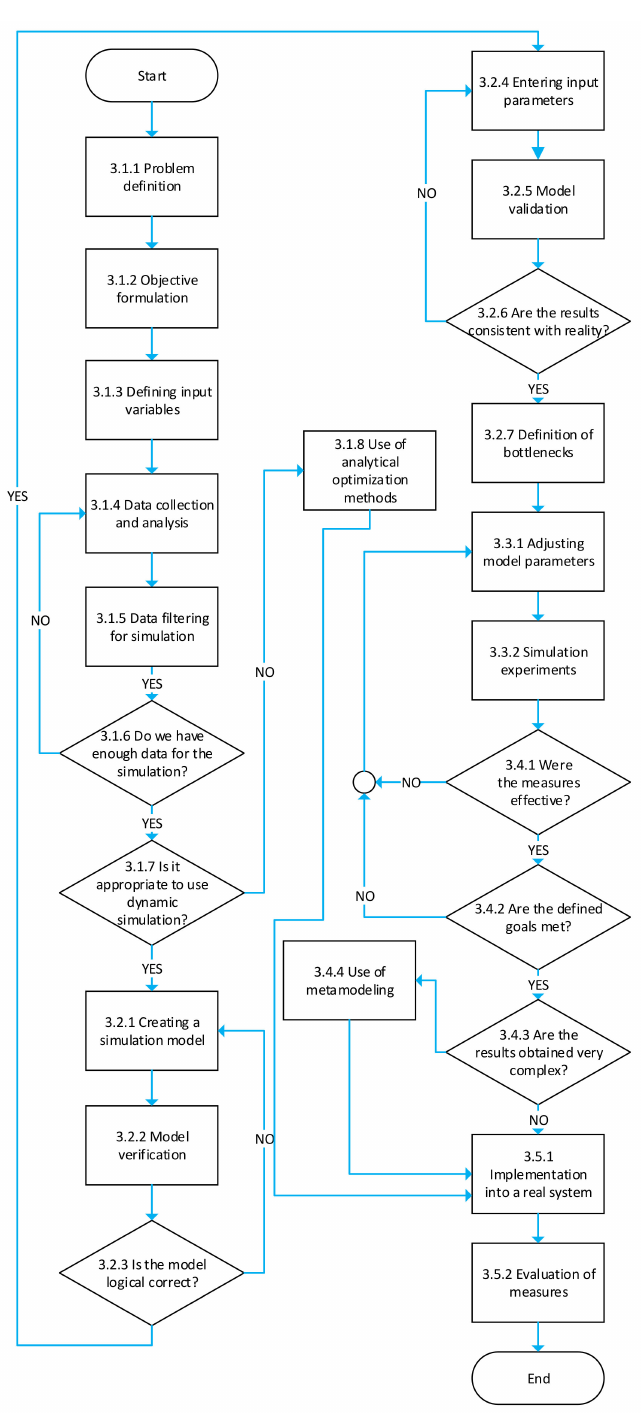
Figure 5. The simulation-model creation